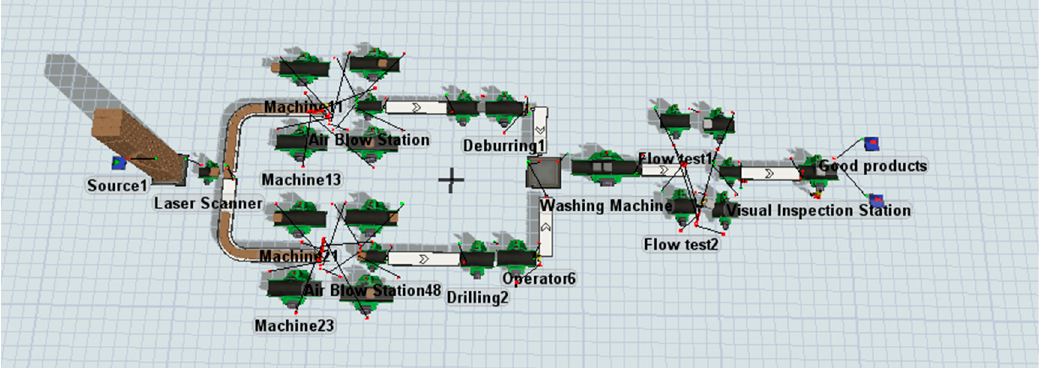
Figure 5 . Model of human operated line.